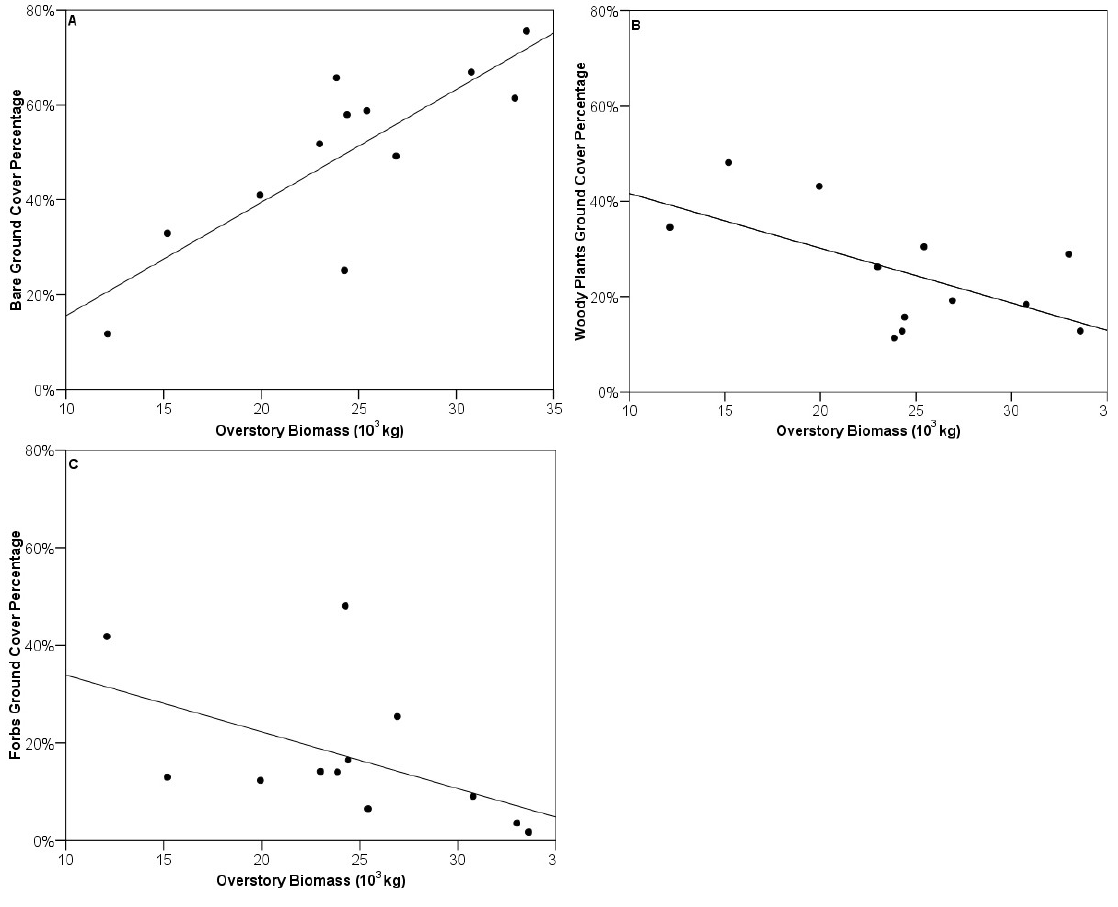
Figure 5. Linear Regressions between Overstory Biomass and Ground-cover. Relationships are shown between overstory biomass ( x axis) and percent bare ground-cover ( (a) , R 2 = 0.67, p < 0.01), percent woody plant ground-cover ( (b) , R 2 = 0.37, p = 0.04),